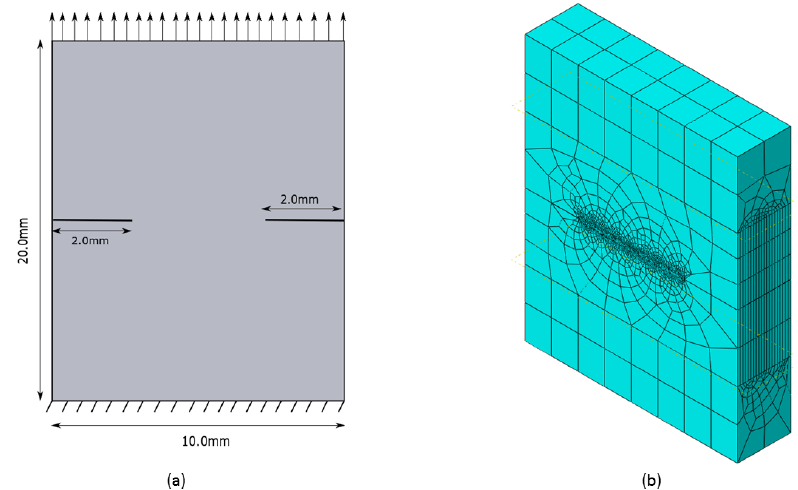
Figure 7. A double edge notched tensile sample: ( a ) 2D Geometric representation of the structure; thickness = 2.0 mm; and ( b ) biased hexahedral